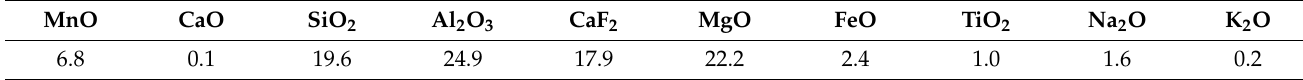
Table 2. Flux bulk chemical composition (mass%). [27].